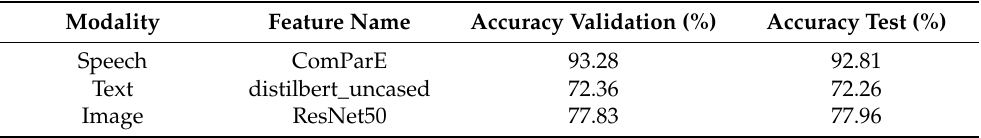
Table 4. Best performing features for each